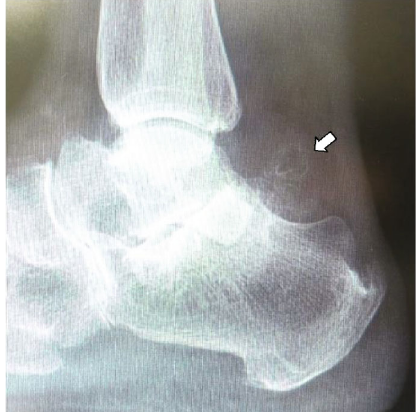
Figure 2: Lateral plain radiographic view of the right ankle obtained preoperatively showing several ossi fi ed masses in the posterior ankle area